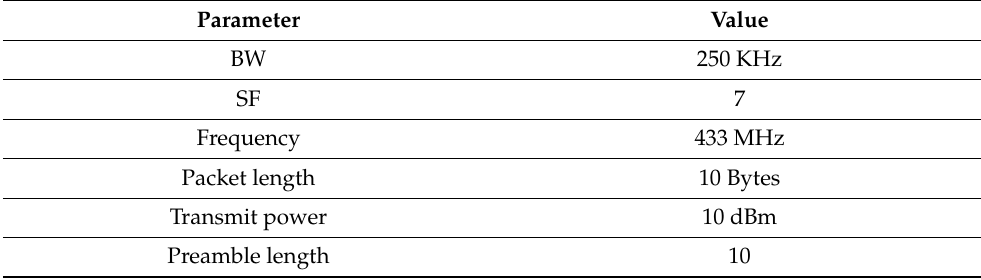
Table 2. Test parameter configuration.